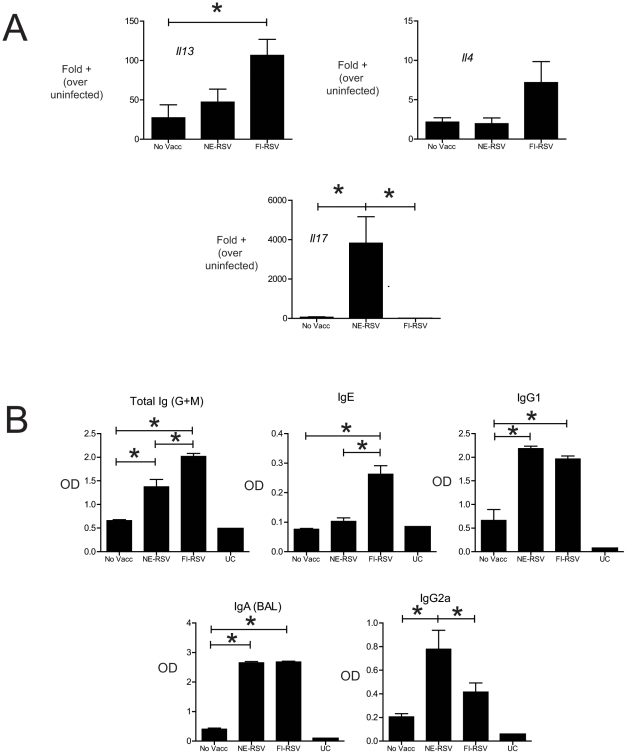
NE-RSV vaccination and FI-RSV vaccination promote distinct cytokine and antibody responses.Mice were vaccinated with NE-RSV or FI-RSV, as described, and challenged with live RSV. In (A), the expression of Th2/Th17 type cytokines was assessed from lung RNA via QPCR. In (B), the levels of RSV specific serum immunoglobulin and BAL IgA were determined by ELISA. Columns represent the mean of five mice per group +/− SEM. * = p<0.05, as assessed by ANOVA followed by Tukey's multiple comparison test. All other pairwise comparisons were not statistically significant.